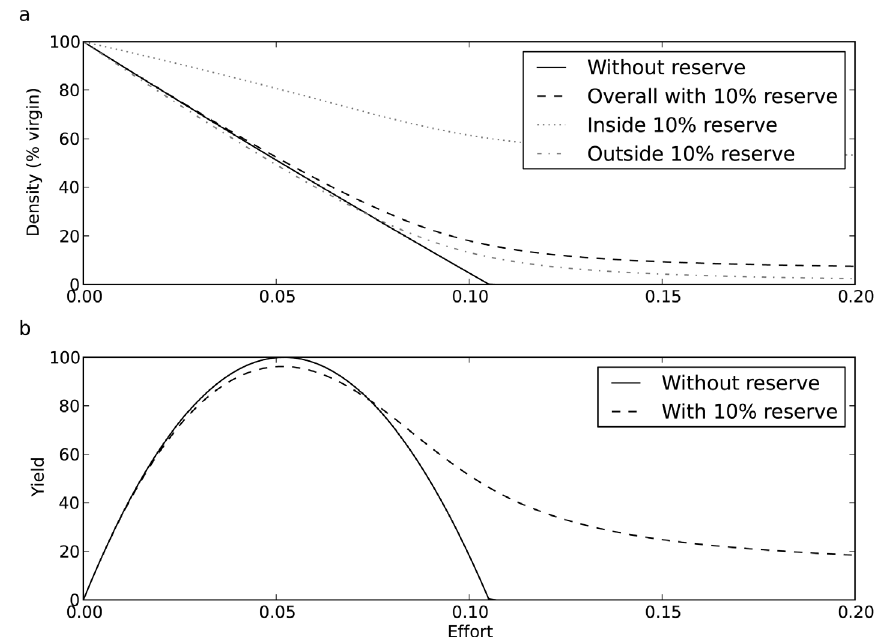
Figure 1. Changes in population and fishery dynamics resulting from the introduction of a reserve. (a) The equilibrium biomass density as a function of fishing effort. The density is shown for the whole stock without a reserve and with a 10% reserve. For the reserve scenario the density inside and outside of the reserve is also shown. (b) Yield as a function of fishing effort both with and without a reserve.